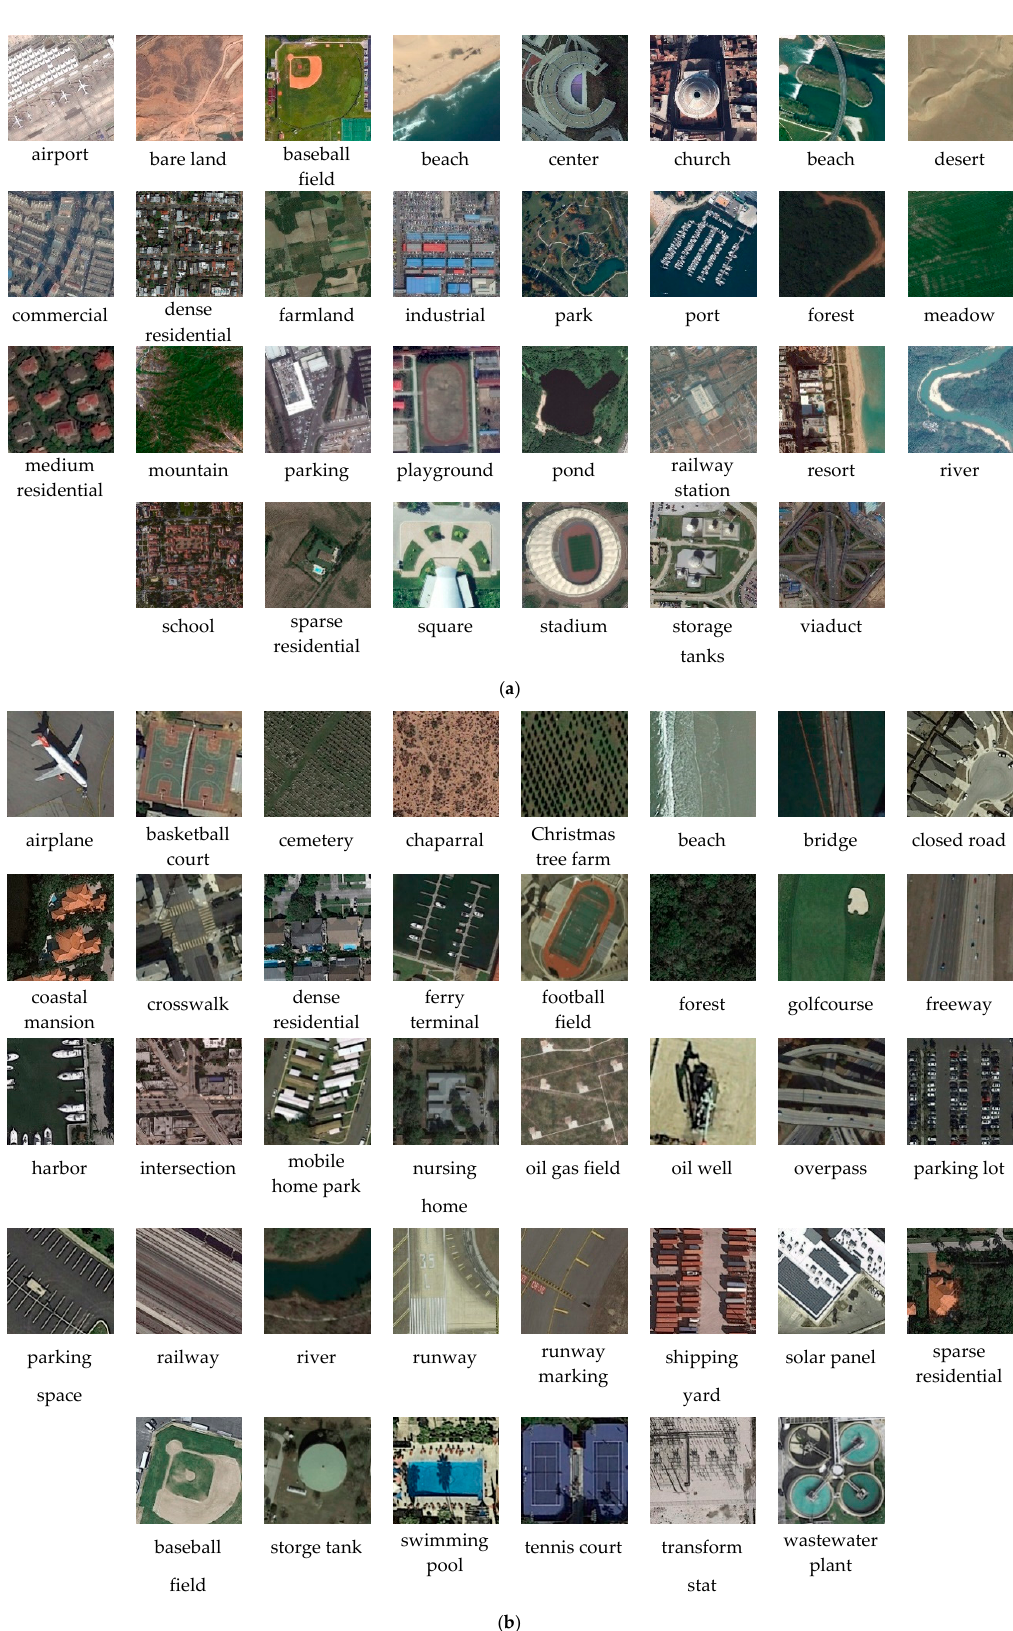
Figure 7. Samples images from the datasets AID and PatternNet, ( a ) examples from dataset AID, ( b ) examples from dataset PatternNet.